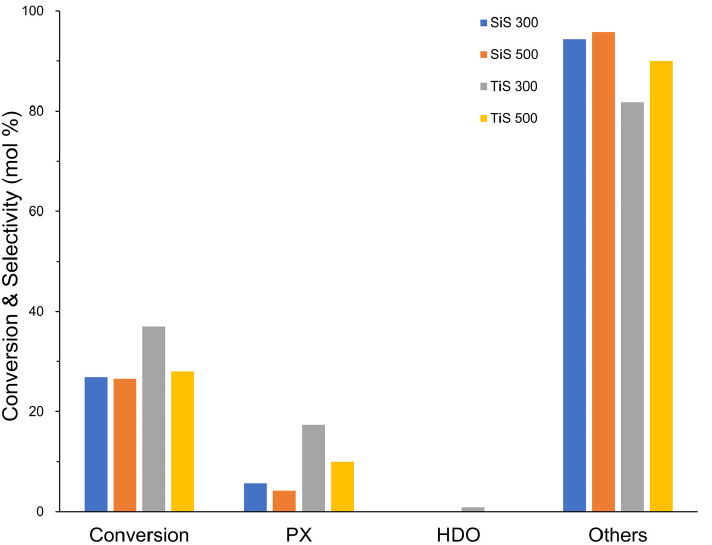
Figure 5. Conversion of DMF and selectivity of PX and HDO for the Diels–Alder reaction of DMF and ethylene over sulfated catalysts. Reaction condition; temperature = 523 K, reaction time = 6 h, C 2 H 4 pressure = 30 bar, DMF = 11.1 wt. %, catalyst mass = 300 ± 5